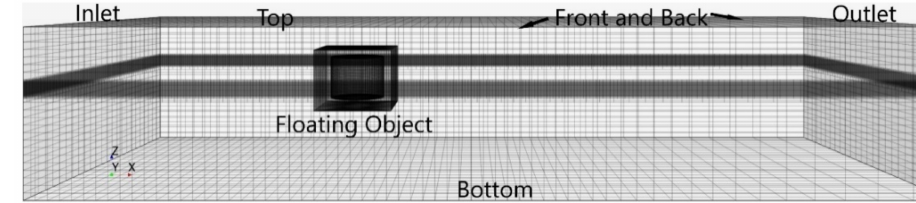
Figure 5. Perspective view of the computational domain.